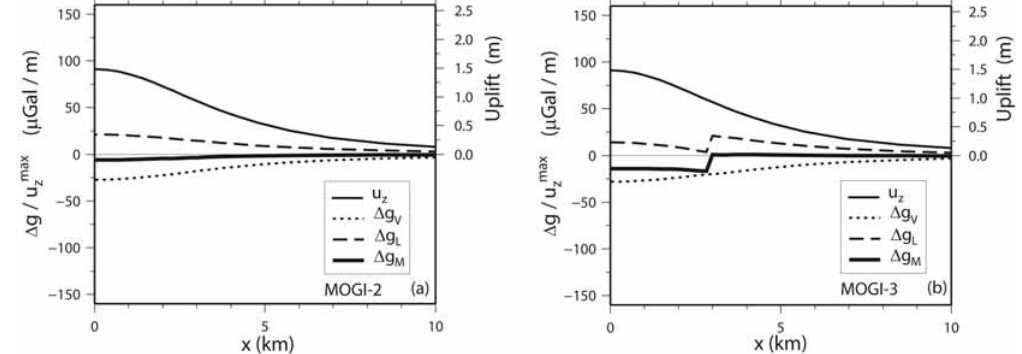
Fig. 8a,b. Gravity terms normalized to the maximum uplift u z max , and vertical displacement due to an inflating spherical pressure source in a medium characterized by density contrasts of 30% in: a) shallow layer of height 3 km; b) cylindrical caldera.